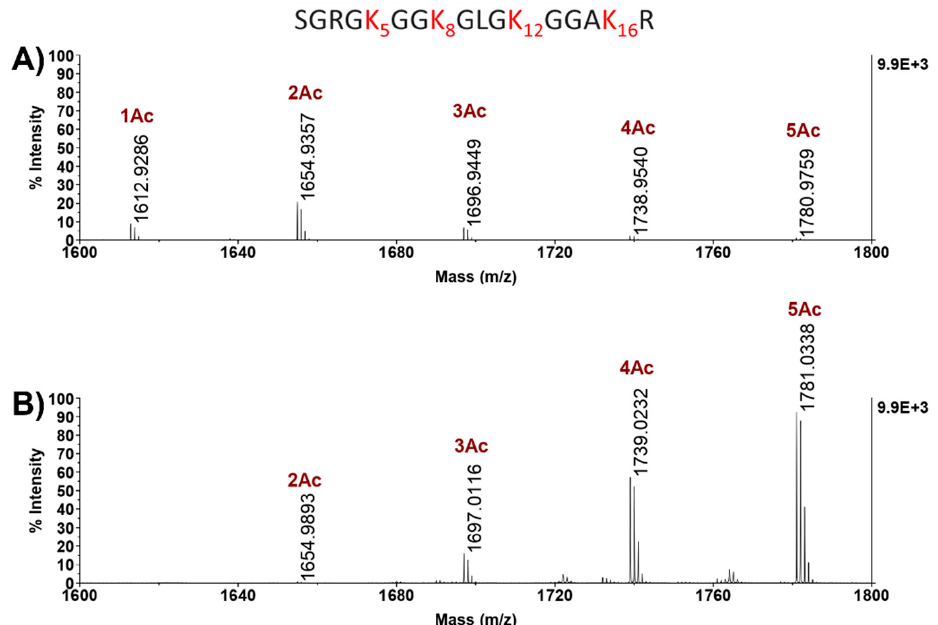
Figure 3. Partial histone H4 MALDI-MS spectra of E14 ES mouse treated cells. m / z signals of differently modified species relative to peptide 1–17 are highlighted in DMSO- ( A ), and TSA-treated cells ( B ). Peptide 1–17 sequence is reported upper in figure; in red K residues are highlighted, as potential targets of acetylation, in addition to the N-terminus. Ac: acetyl group. The spectra are reported in the same scale of intensity.